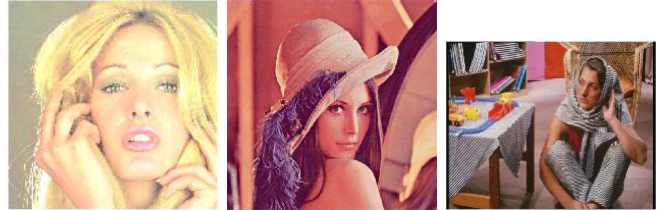
Figure 3. The original test images: From ( left ), Tiffany, Lenna ( middle ), and Barbara ( right )